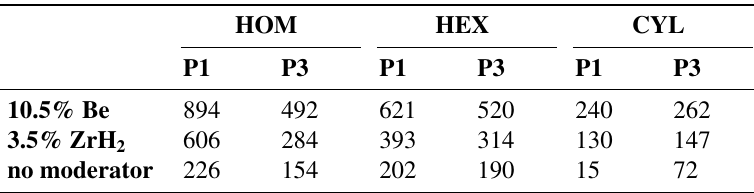
Table 3: Biases on control rods worth in pcm for A3-T4 scheme (33 groups in T4)